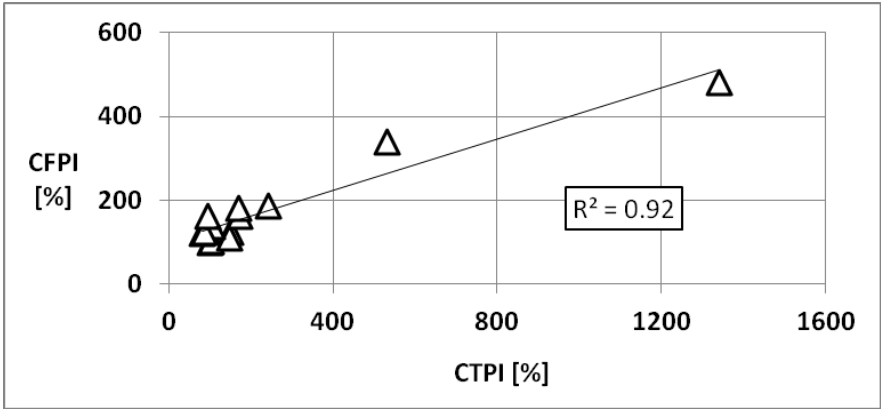
Figure 10. The relationship between significantly reliable (CFPI) and highly simplified (CTPI) machinability indexes which were determined for all the fourteen tested materials. 10